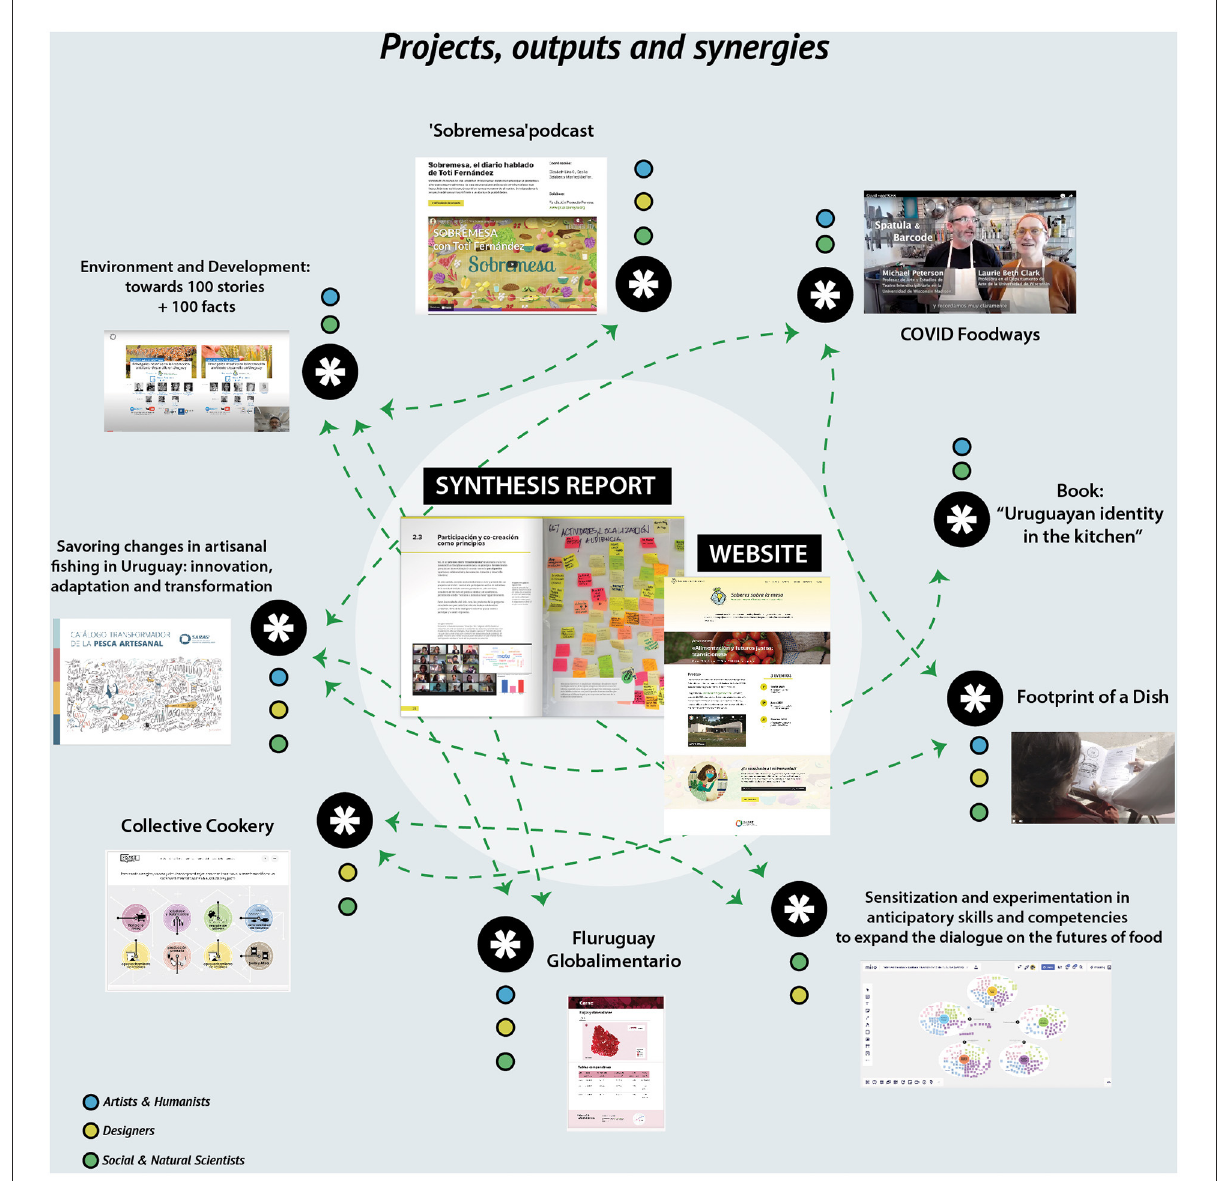
FIGURE3 Overview of the nine projects completed within the Cycle and their synergies. The graphic includes a snapshot of the products to highlight the visual components and the broad knowledge domains